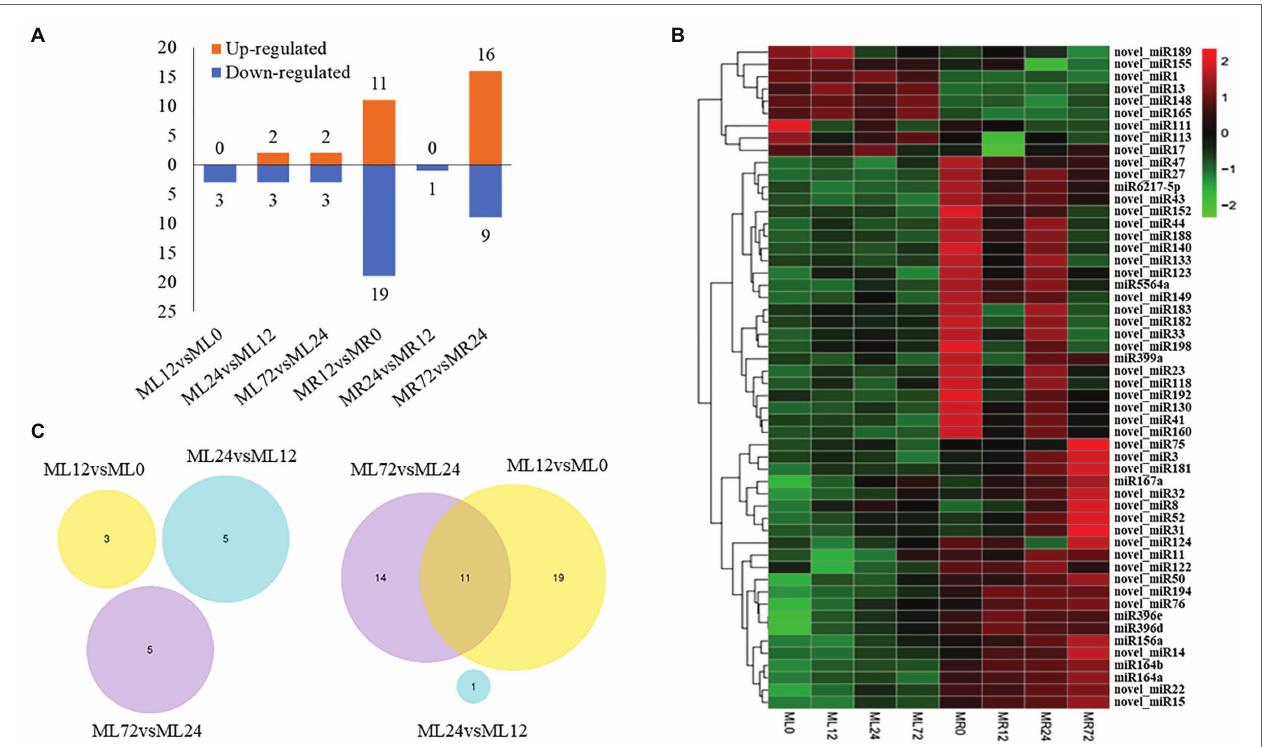
FIGURE 1 | The identified differentially expressed microRNA (miRNA) response to Chromium (Cr) stress. (A) The histogram showed the number of upregulated and downregulated differentially expressed miRNAs caused by Cr treatment of six comparison groups. (B) Heat map of the expression levels of 54 differentially expressed miRNAs. Different colors indicate different expression levels, as shown in the scale. (C) Venn diagram showed the number of differentially expressed miRNAs in different comparison groups.